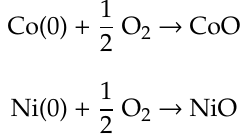
Figure 15. Temperature programmed oxidation (TPO) profiles of Co 2 Ni 2 Mg 2 Al 2 800 after the dry reforming of methane in the absence and in the presence of 180 ppm of toluene.